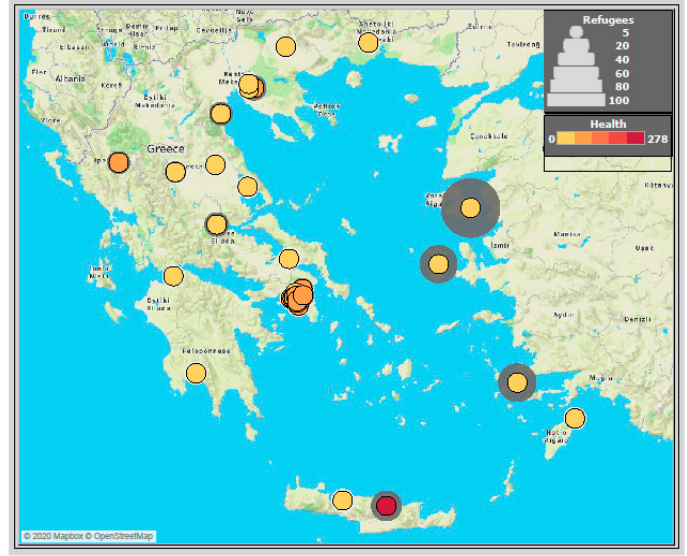
Figure 2. Spatial map of Google Trends based on refugee or health-related data, Greece (January 2008–March 2020). Note: The figure is based on the map provided by Google Trends. The color gradient and the size of the circle correlate with the volume of “health” or ”refugees”-related Web searches in Greece, respectively.